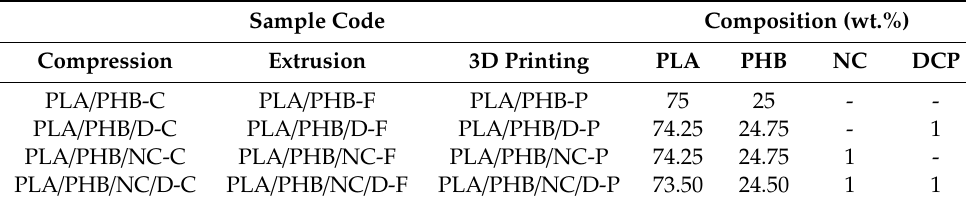
Table 1. Nanocomposites formulations and notation after di ff erent processing